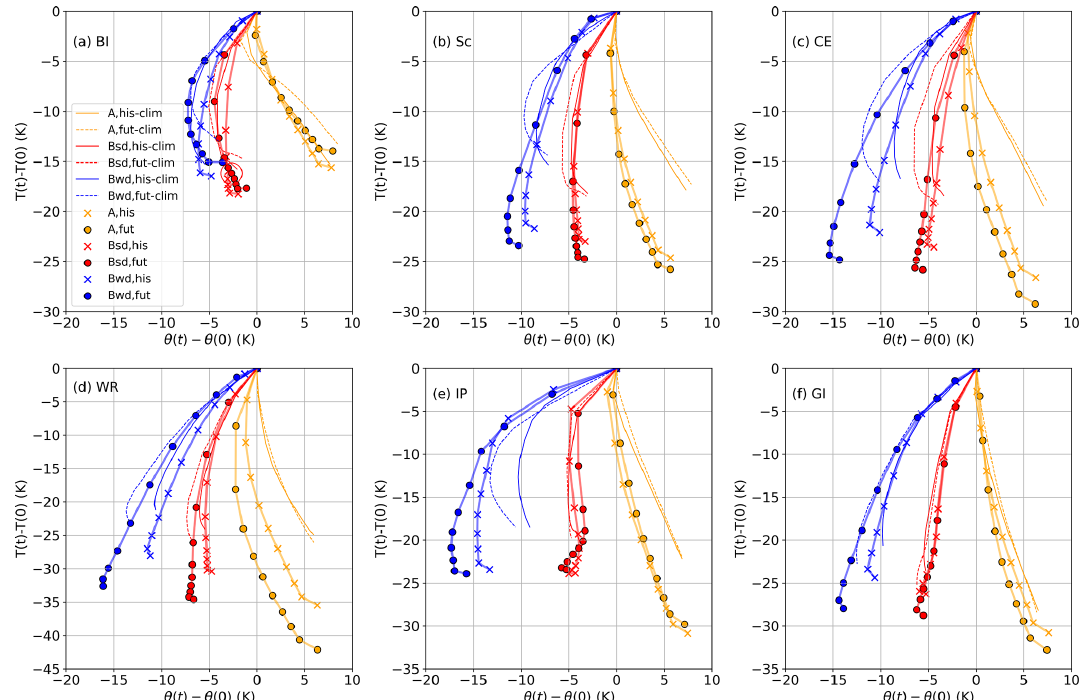
Figure 10. Median temperature and potential temperature evolution along the air parcel trajectories for each cluster (A: yellow; Bsd: red; and Bwd: blue) relative to the values on the heatwave day in the six European regions, i.e., the point with coordinates (0, 0). Dots and crosses indicate the values in intervals of 24h, always at 12:00UTC. Note the different ranges of the temperature axis ( y axis) for the different regions. Thin lines correspond to historic (solid) and future (dashed) climatological medians. A significance test (Welch’s t test) was performed with a significance level ( p value) of 0.05. Large, open circles in the plots indicate insignificant ( p values > 0.05) differences between the medians of future and historic